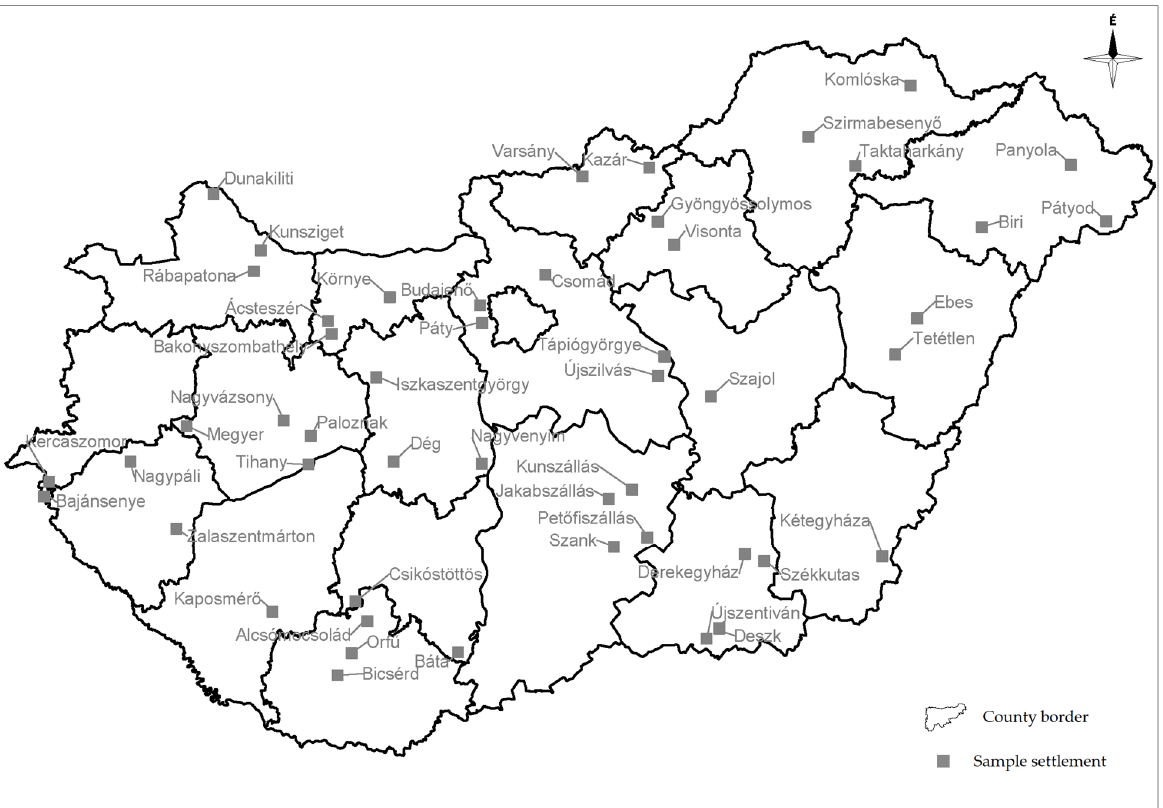
Figure 2. Location of sample settlements.